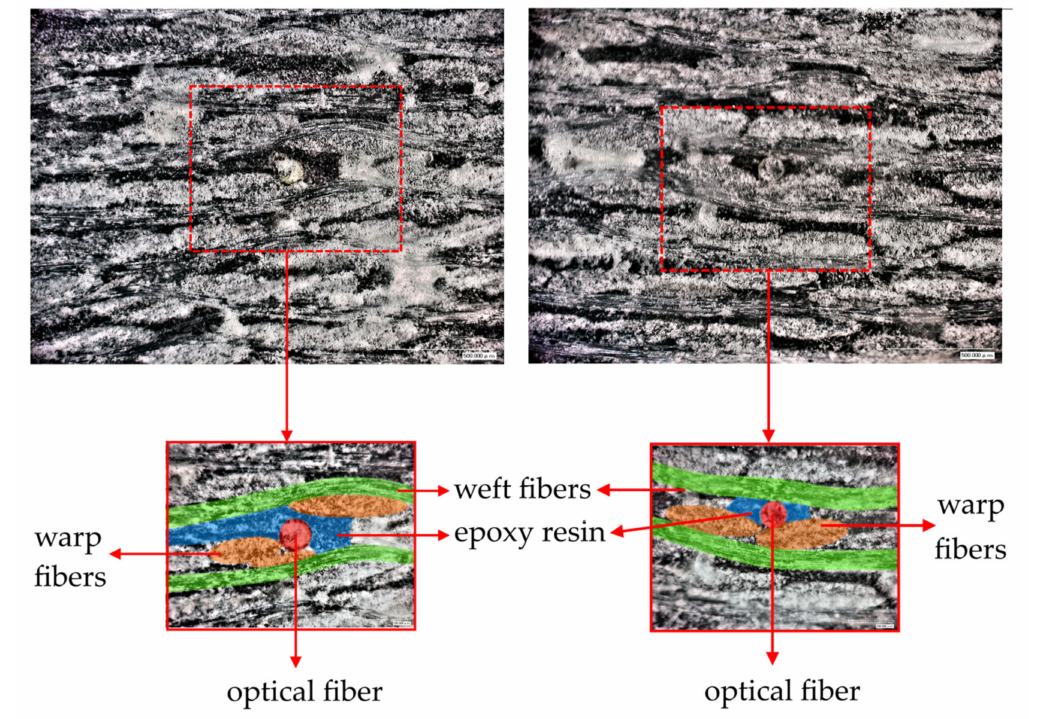
Figure 5. Photos of sample cross-sections.